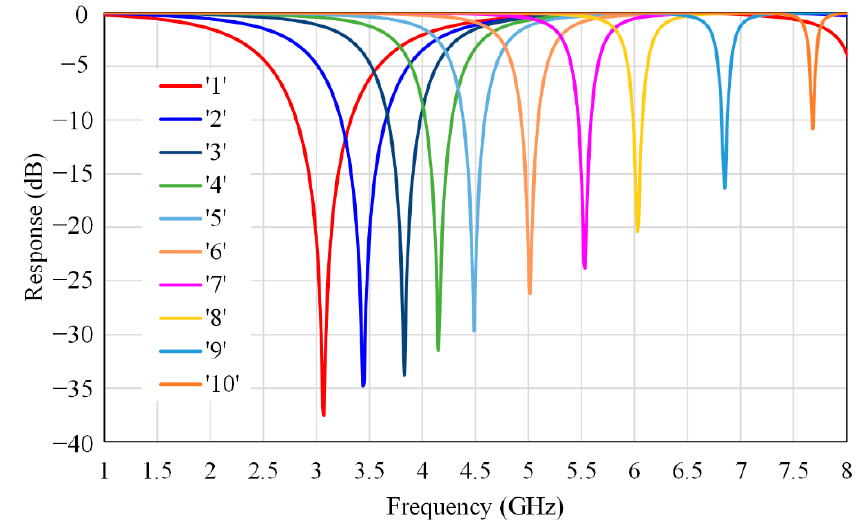
Figure 4. Simulated response of the overturned M − shaped strips (one by one).